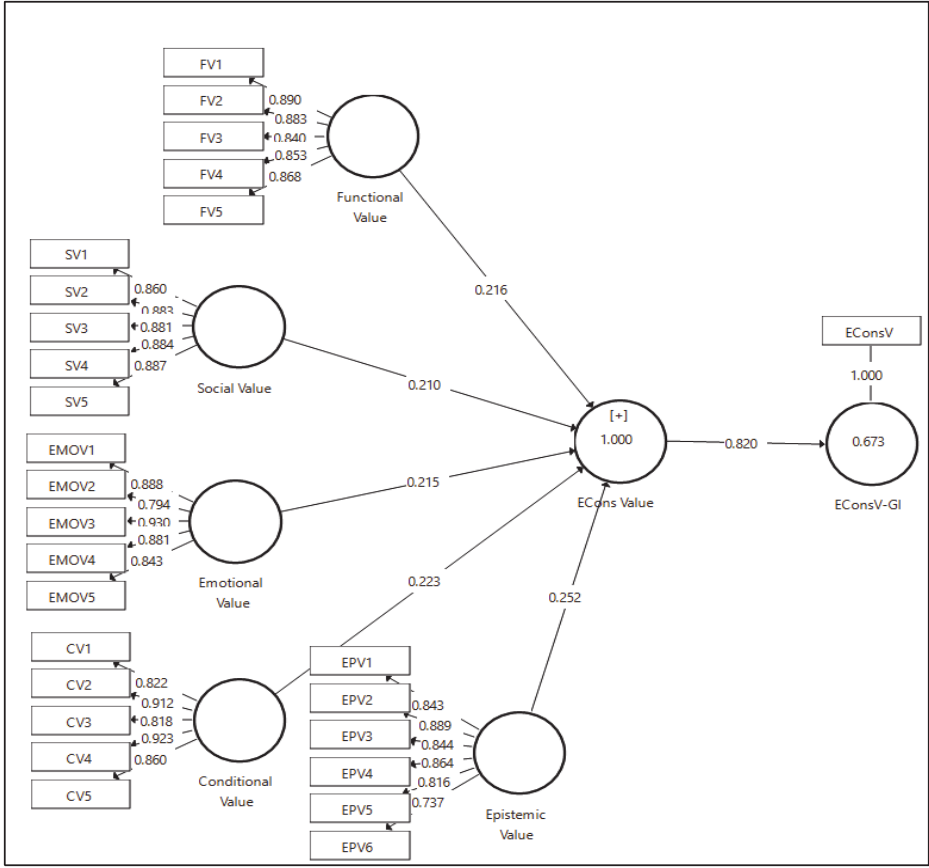
Fig. 3. Assessment of Second-Order Construct Measurement